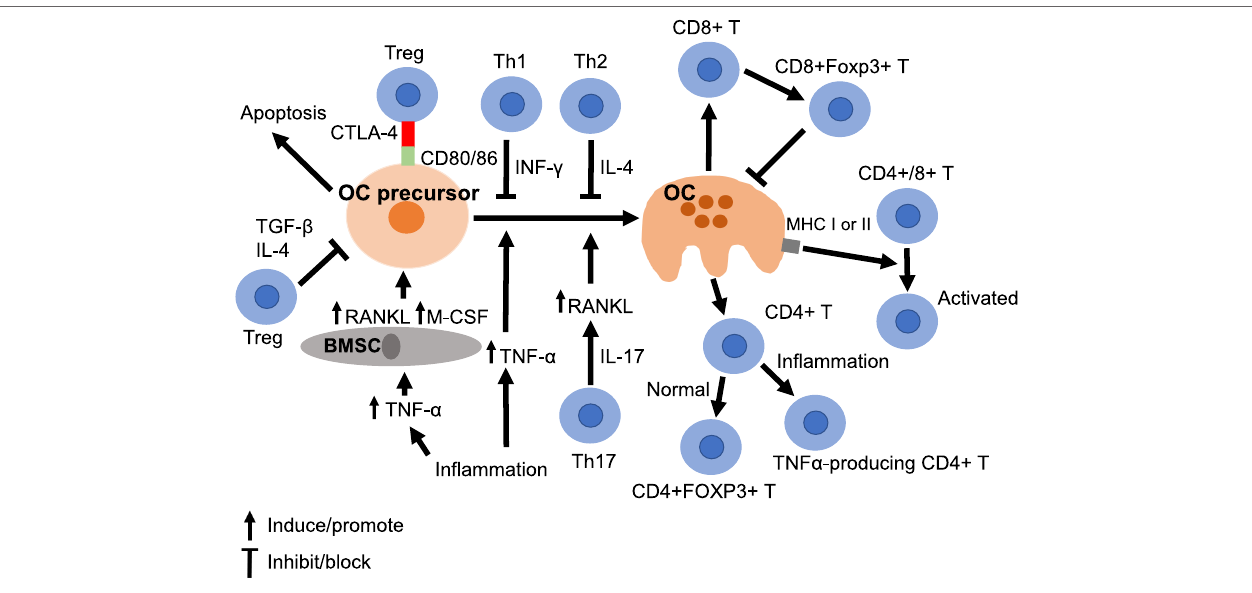
FigURe 2 | Osteoclasts crosstalk with immune cells. The differentiation of OCs from its precursor (OC precursor) is mediated by multiple cytokines. For example, inflammation induces production of tumor necrosis factor α (TNF α ), which activates OC formation directly or indirectly via BMSC. Another immune cell, the Th17 cell, which produces IL-17, also stimulate OCs via upregulation of receptor activator of nuclear factor- κ B (NF- κ B) ligand. The process of OC differentiation can be inhibited by INF- γ and IL4 produced by Th1 and Th2 cells, respectively. In parallel, T regulatory cells (Tregs) can inhibit OC precursors by secretion of TGF- β and IL-4. CTLA 4 expressed on Tregs can bind to CD80/86 on OC precursors and further influence the fate of OC precursors. OCs can activate several immune cells. First, OCs induce formation of CD8 + FOXP3 + T cells, which in turn inhibit OCs. Second, OCs can act as antigen-presenting cells to promote immune response of CD4 or CD8 T cells. Third, OCs can induce differentiation of CD4 + T cell to TNF α -producing cells or CD4 + FOXP3 + T cells, dependent on the surrounding microenvironment. BMSC, bone marrow stromal cell; IL, interleukin; INF, interferon; M-CSF, macrophage-colony-stimulating-factor; TGF, tumor growth factor; TNF, tumor necrosis factor; Treg, regulatory T